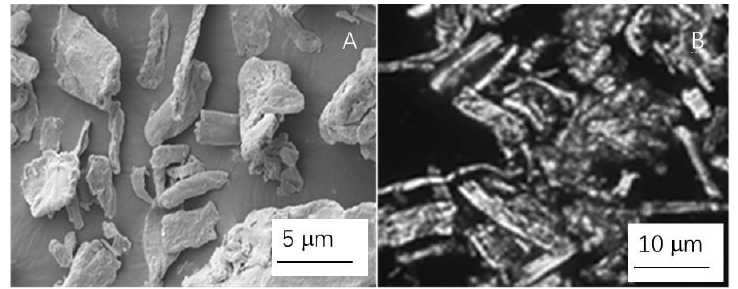
Figure 1. Cellulose crystals under SEM ( A ) and optical microscope polarized lights ( B ).